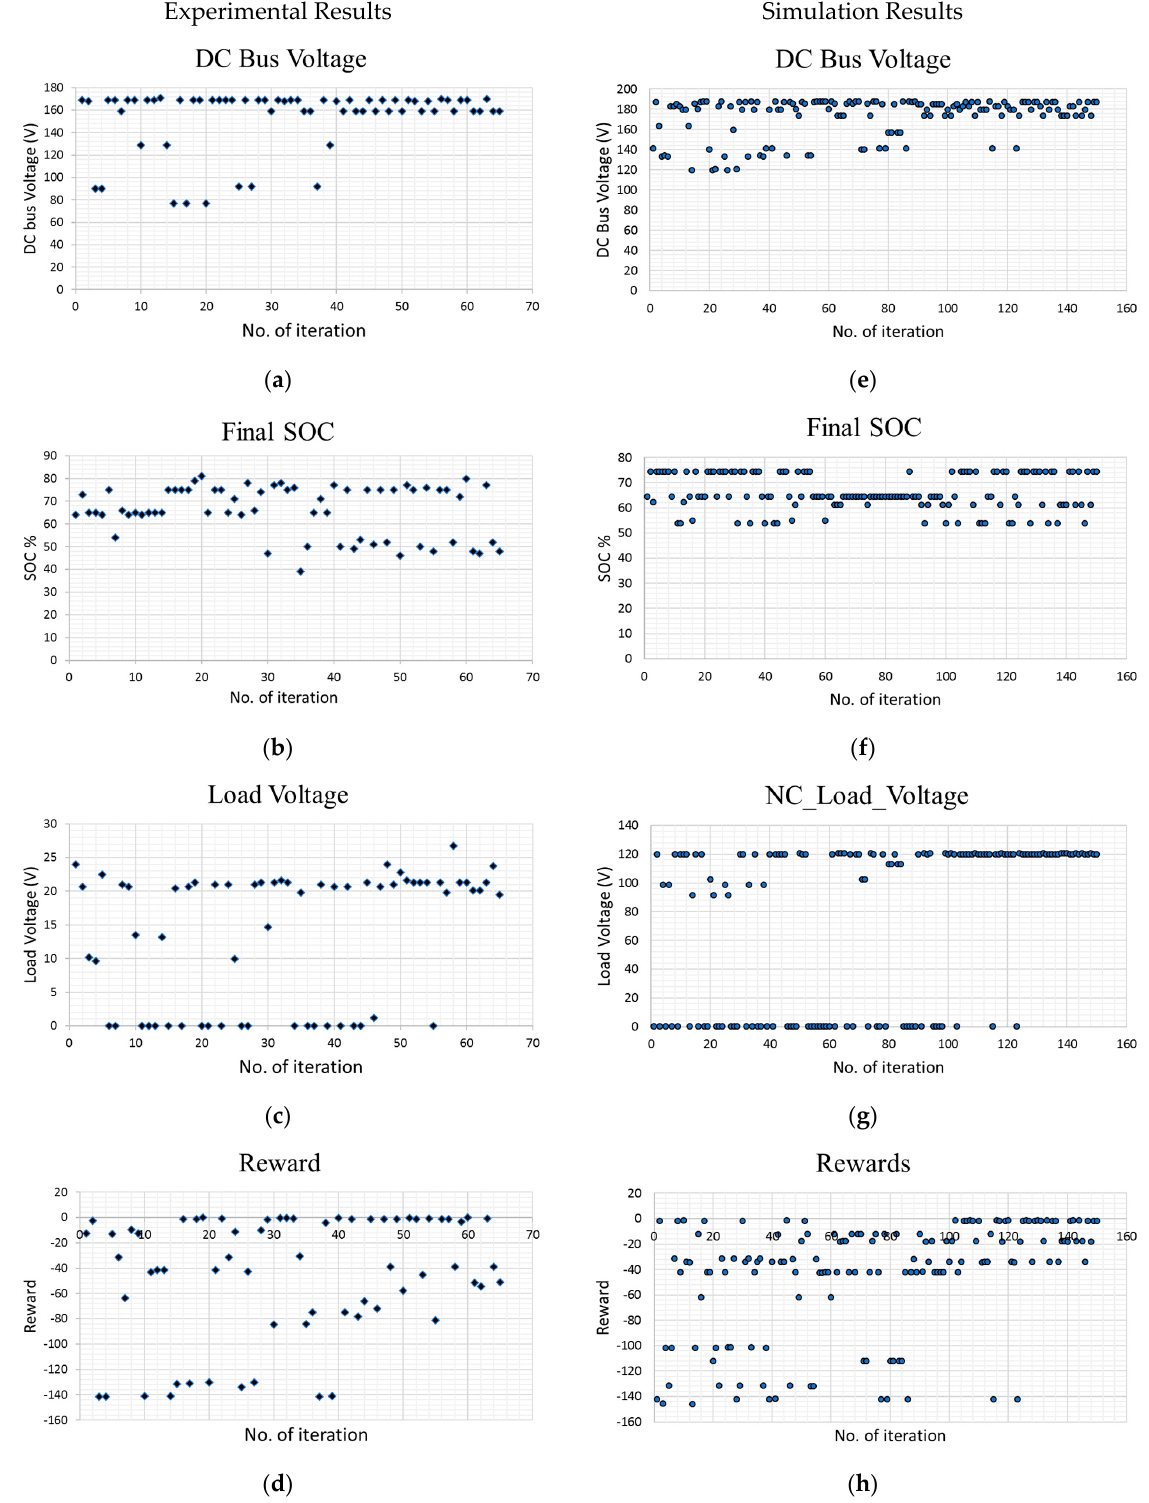
Figure 10. Results of Q-learning ( a ) DC bus voltage—experimental results, ( b ) Final battery SoC— experimental results, ( c ) NC load voltage—experimental results, ( d ) Total rewards—experimental results, ( e ) DC bus voltage—simulation results, ( f ) Final battery SoC—simulation results, ( g ) NC load voltage—simulation results, ( h ) Total rewards—simulation